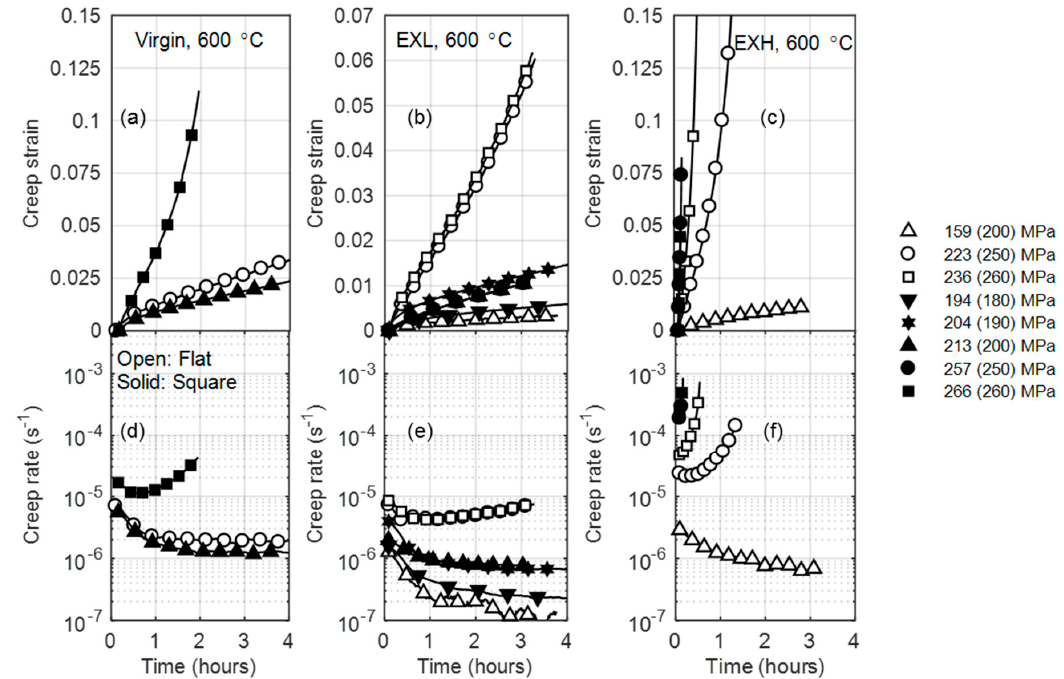
Figure 5. Creep strain and creep rate curves for virgin ( a , d ), EXL—Low damage ex-service ( b , e ), and EXH—High damage ex-service ( c , f ) material at 600 °C and various stresses. Open and solid symbols refer to the flat (2 × 10 mm 2 ) and standard square (10 × 10 mm 2 ) geometries, respectively. True stresses are reported (with applied stress in brackets) in the legend.